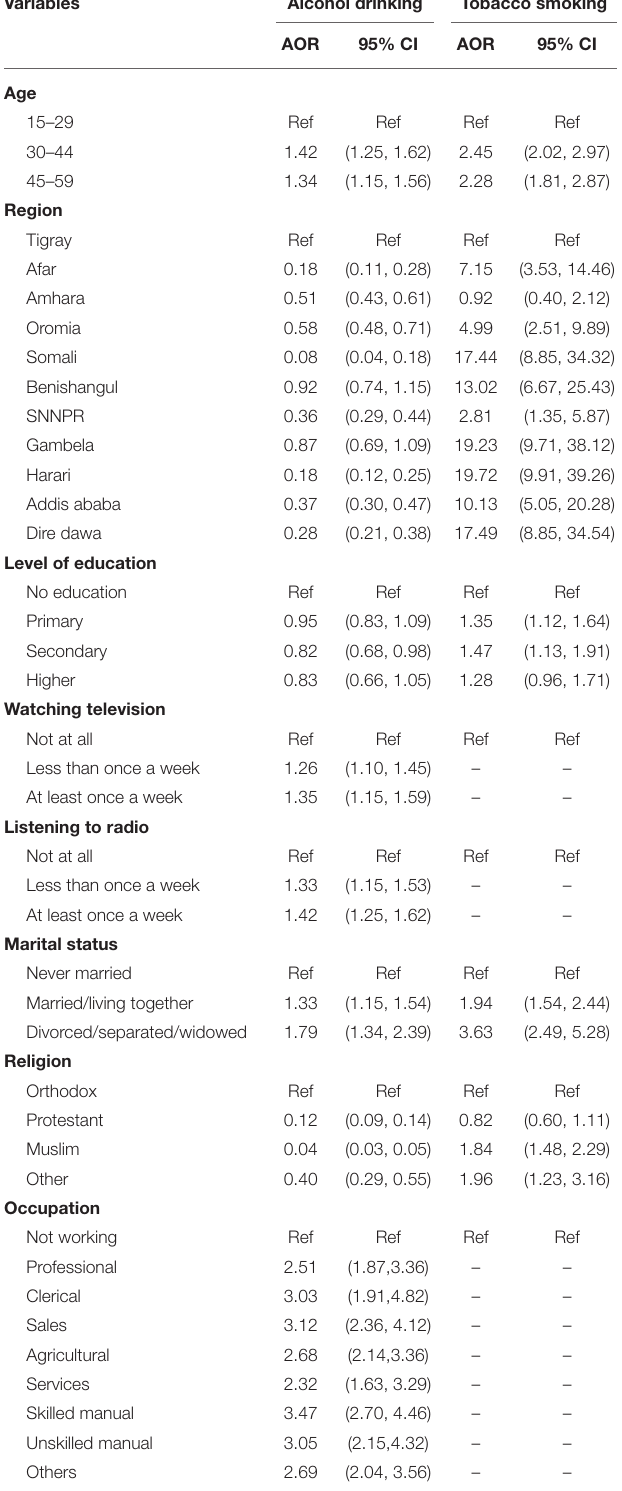
TABLE 4 | Associated factors of risky health behavior among adult males in Ethiopia, 2016.